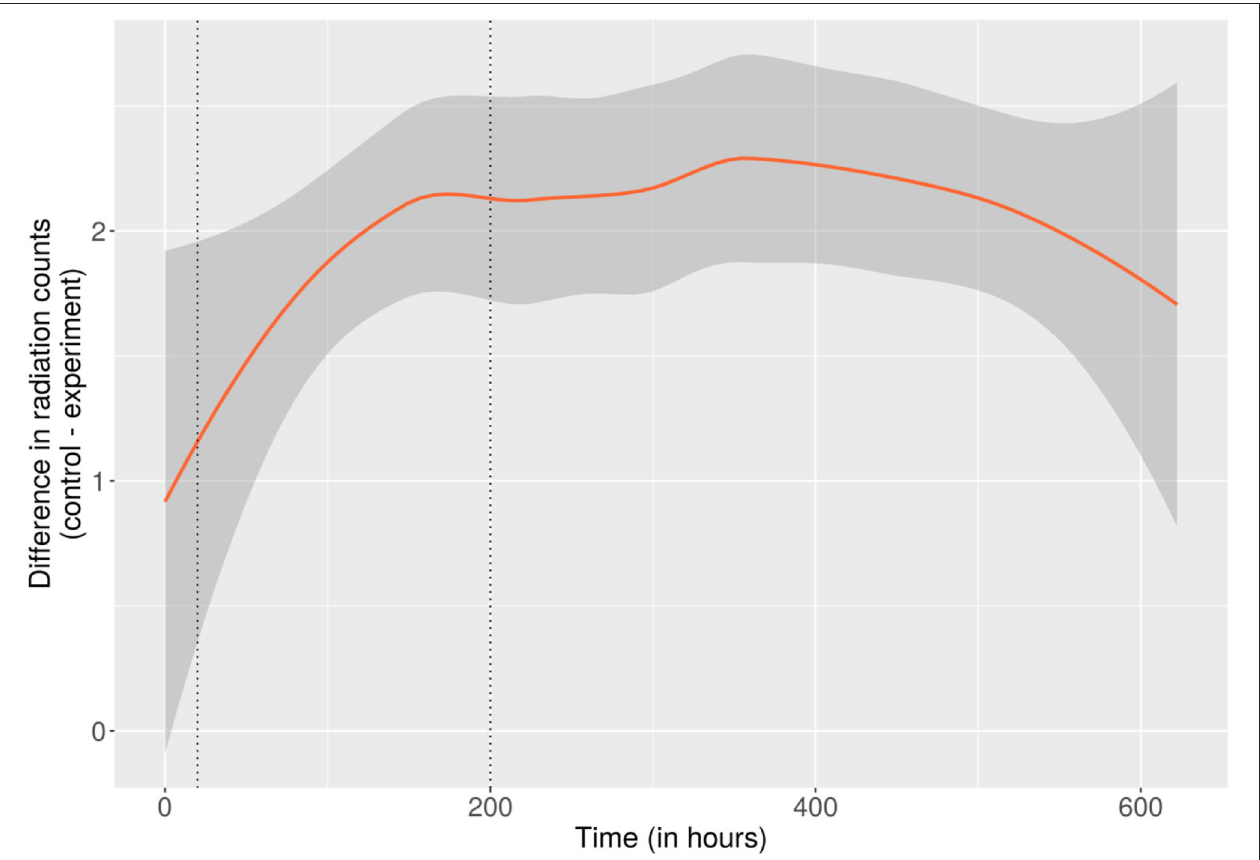
FIGURE 3 | Difference between the incremental radiation counts of the control- and the fungus-side of the on-orbit experiment over the runtime of the experiment. As such, the trendline displays the average difference between the radiation counts measured at intervals of ∼ 1.5m of locally estimated scatterplot smoothing. The area shaded gray around the trendline corresponds to a 95% confidence band around the smoothed values. Dotted vertical lines were placed for orientation at the time points where growth reached 50% (of the maximum relative OD) and where the formation of biomass and melanin was considered complete (200h). A more significant difference is apparent toward the later 2/3 of the experiment (200–622h), where biomass and melanin content were presumably constant, potentially caused by attenuation of the transmitted radiation. The full dataset and additional plots (incremental and cumulative) of the complete radiation data over the whole course of the experiment can be found in Supplementary Information 2 , under